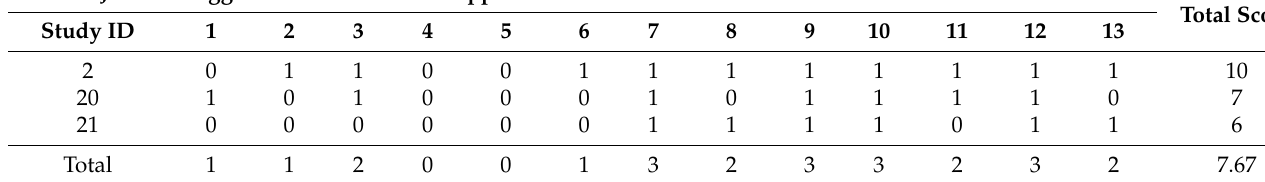
Table 3. Quality assessment of the included